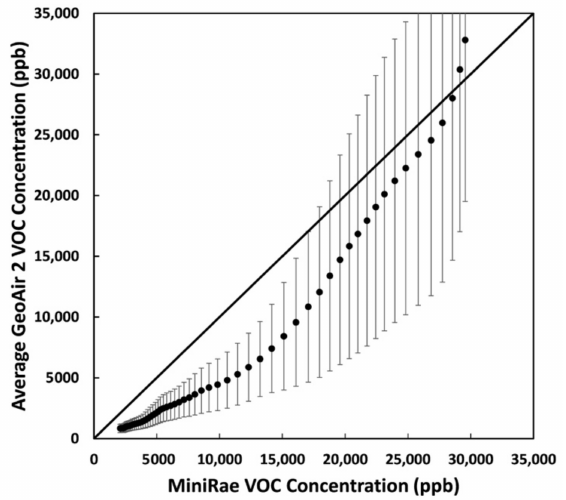
Figure 5. VOC scatter plot for MiniRAE and average GeoAir measurements for 1-Butanol. The y axis error bars represent the standard deviation of the GeoAir